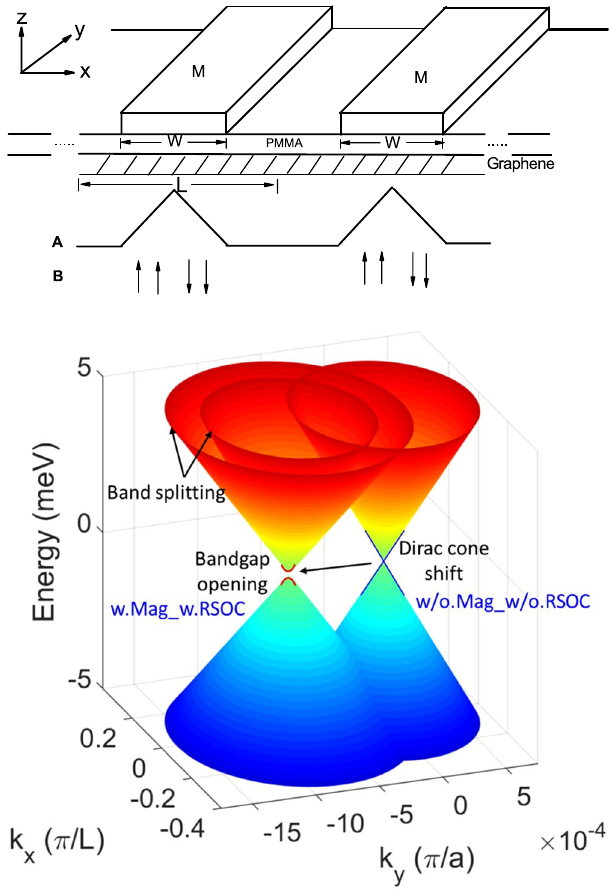
Figure 1. (Top) Schematic diagram of a graphene monolayer coated by periodic magnetic stripes and the vector potential profile in the proposed structure. (Bottom) The Dirac cones of a bare graphene layer and a graphene magnetic superlattice in the precense of the RSOC, with L = 100 nm , W = 50 nm , B = 1 T , R 0 = 10 2 m / s